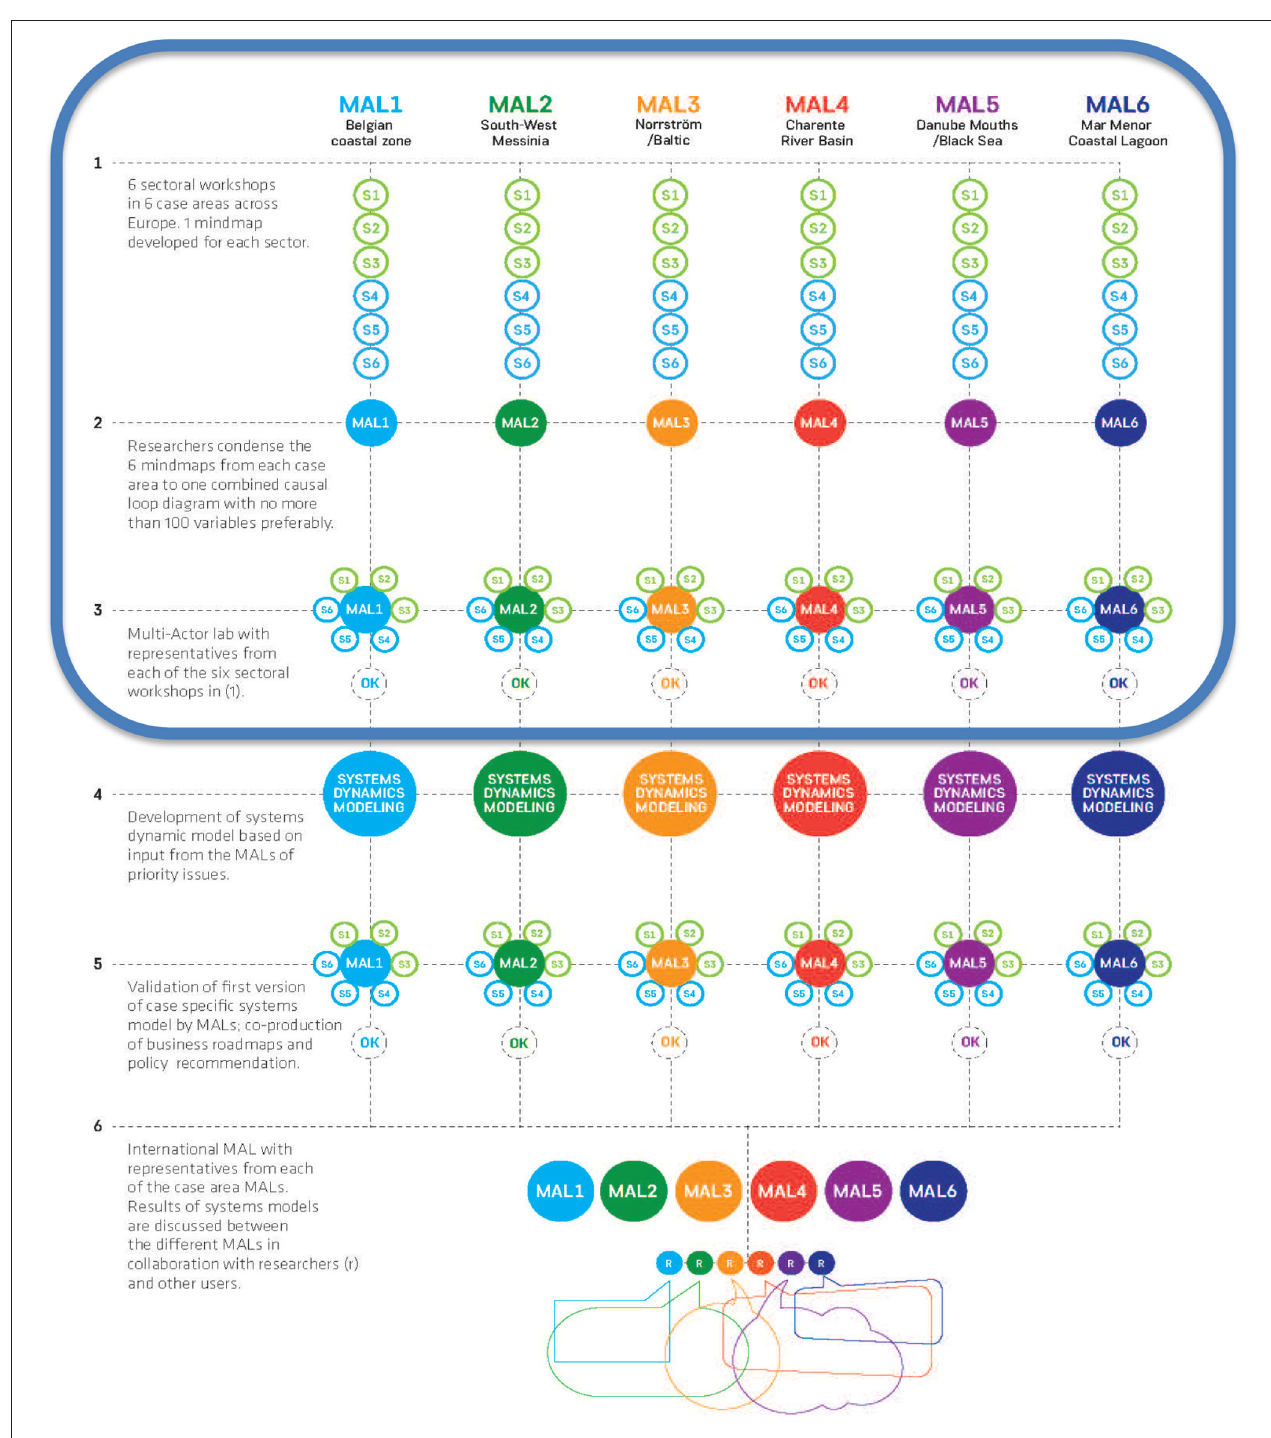
FIGURE 1 | Graphical presentation of the entire stakeholder driven process. This article presents the methodology for the first three parts of the project, which lay the groundwork for possible continuations toward more quantitative models of the work presented here. We had six case areas with six sectoral workshops in each.